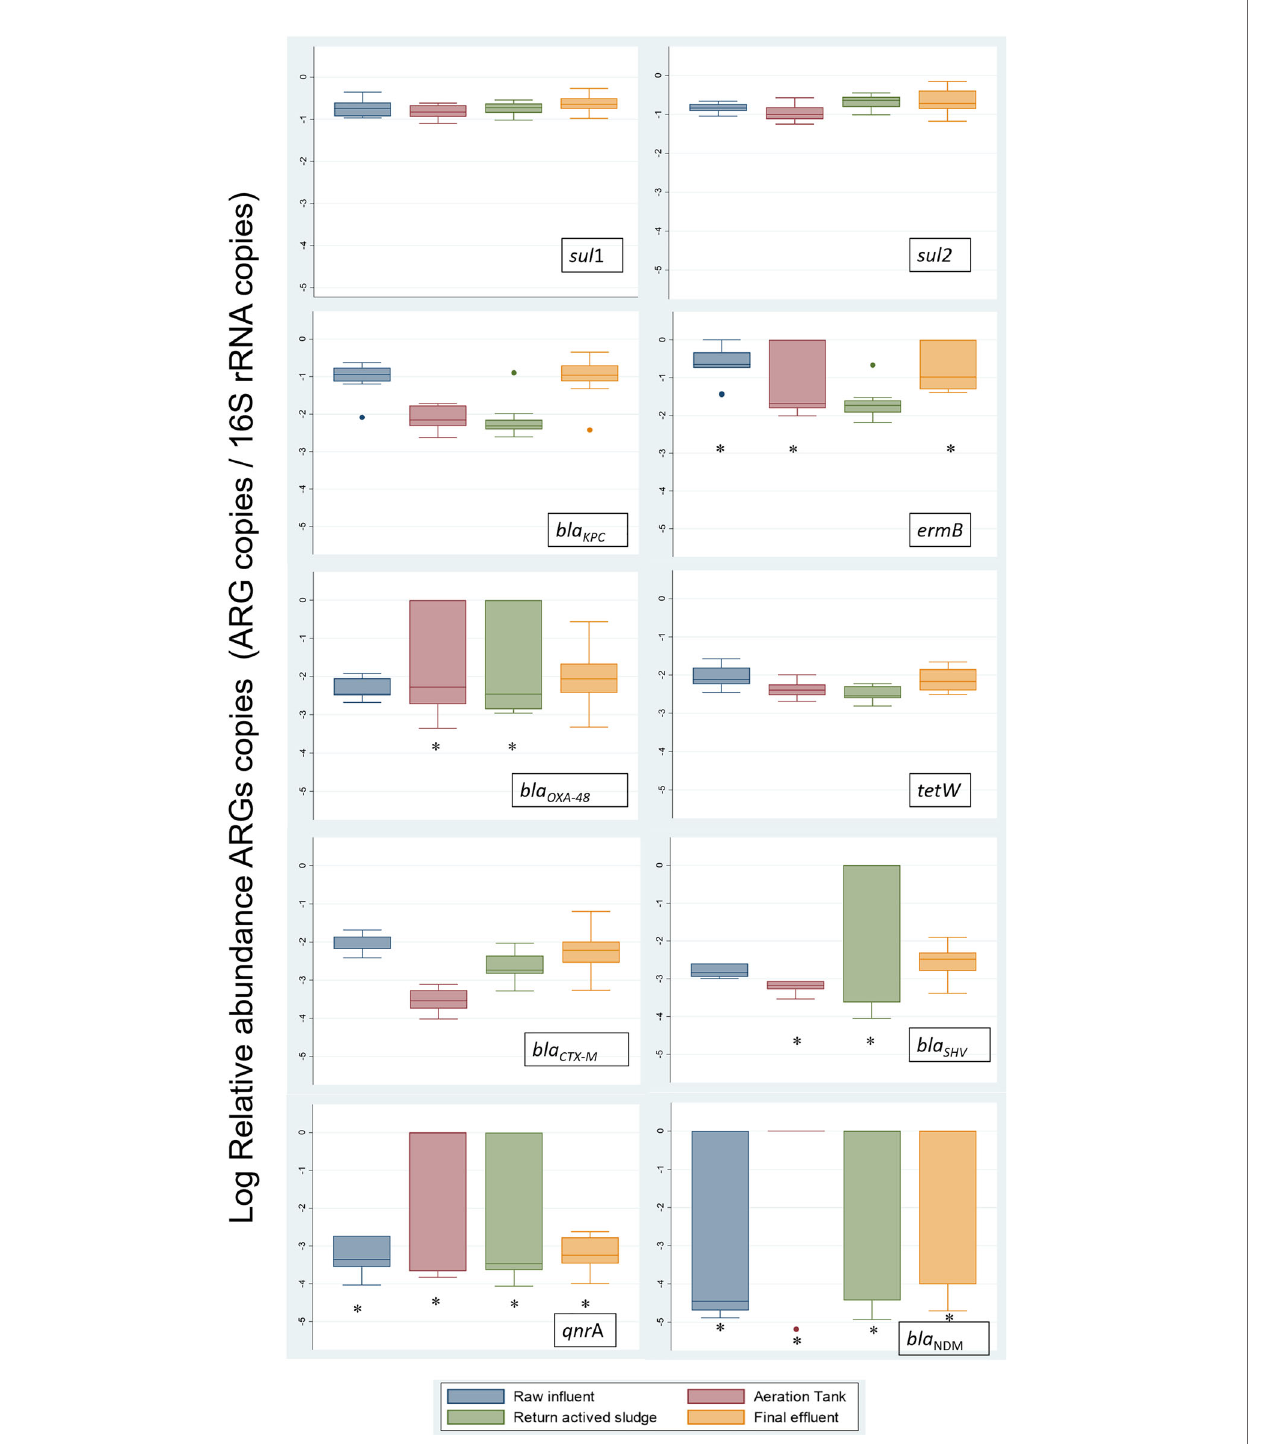
FIGURE 3 | Relative abundance of ARGs in the WWTP. Within the box plot chart, the crosspieces of each box plot represent (from top to bottom) maximum, upper quartile, median (black bar), lower quartile, and minimum values. erm B, bla KPC , bla NDM , bla OXA-48 , bla CTX-M , bla SHV , tet W, and qnr A showed a statistically signi fi cant difference between points ( P <0.05). *ARGs with minimum values below the detection limit ( b.d.l